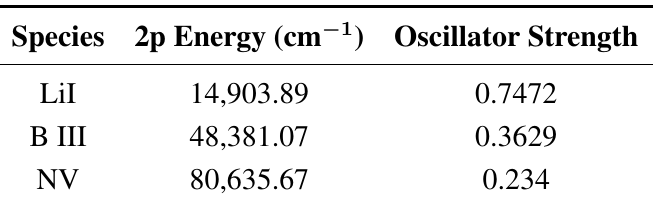
Table A1. 2s-2p Atomic